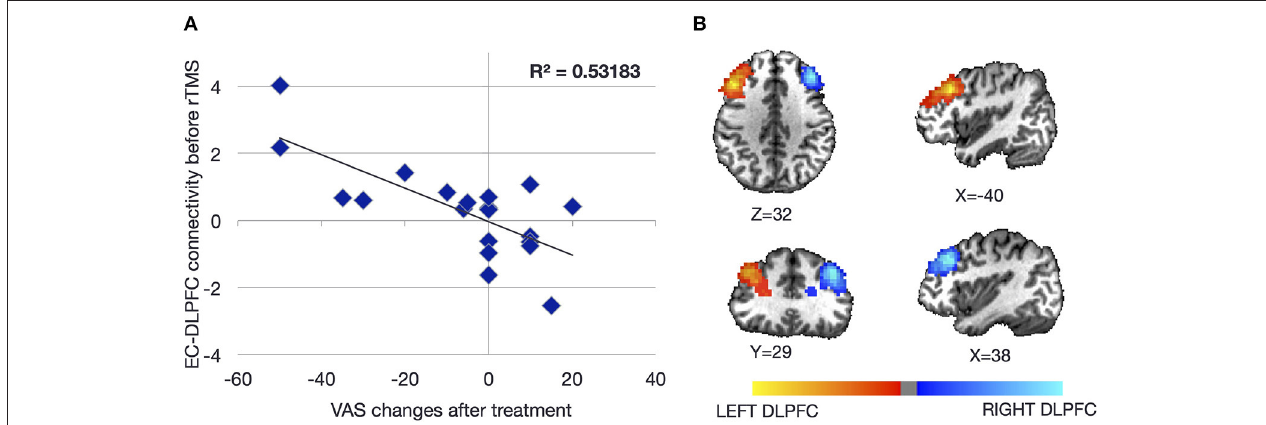
FIGURE 3 | Baseline resting-state functional connectivity between the left and right dorsolateral prefrontal cortices (DLPFCs) and the ipsilateral entorhinal cortex as a function of symptom severity change after repetitive transcranial magnetic stimulation (rTMS) to the DLPFC. Individuals with higher baseline connectivity between the DLPFC and ipsilateral entorhinal cortex responded better to rTMS (A) . The location of each DLPFC was determined from individualized neuronavigation targets aiming for the anterior portion of the middle of the middle frontal gyrus (B) . Coordinates of the entorhinal cortex were determined from individual structural scans. Figure adapted from Yuan et al., Brain Connectivity 2017 (